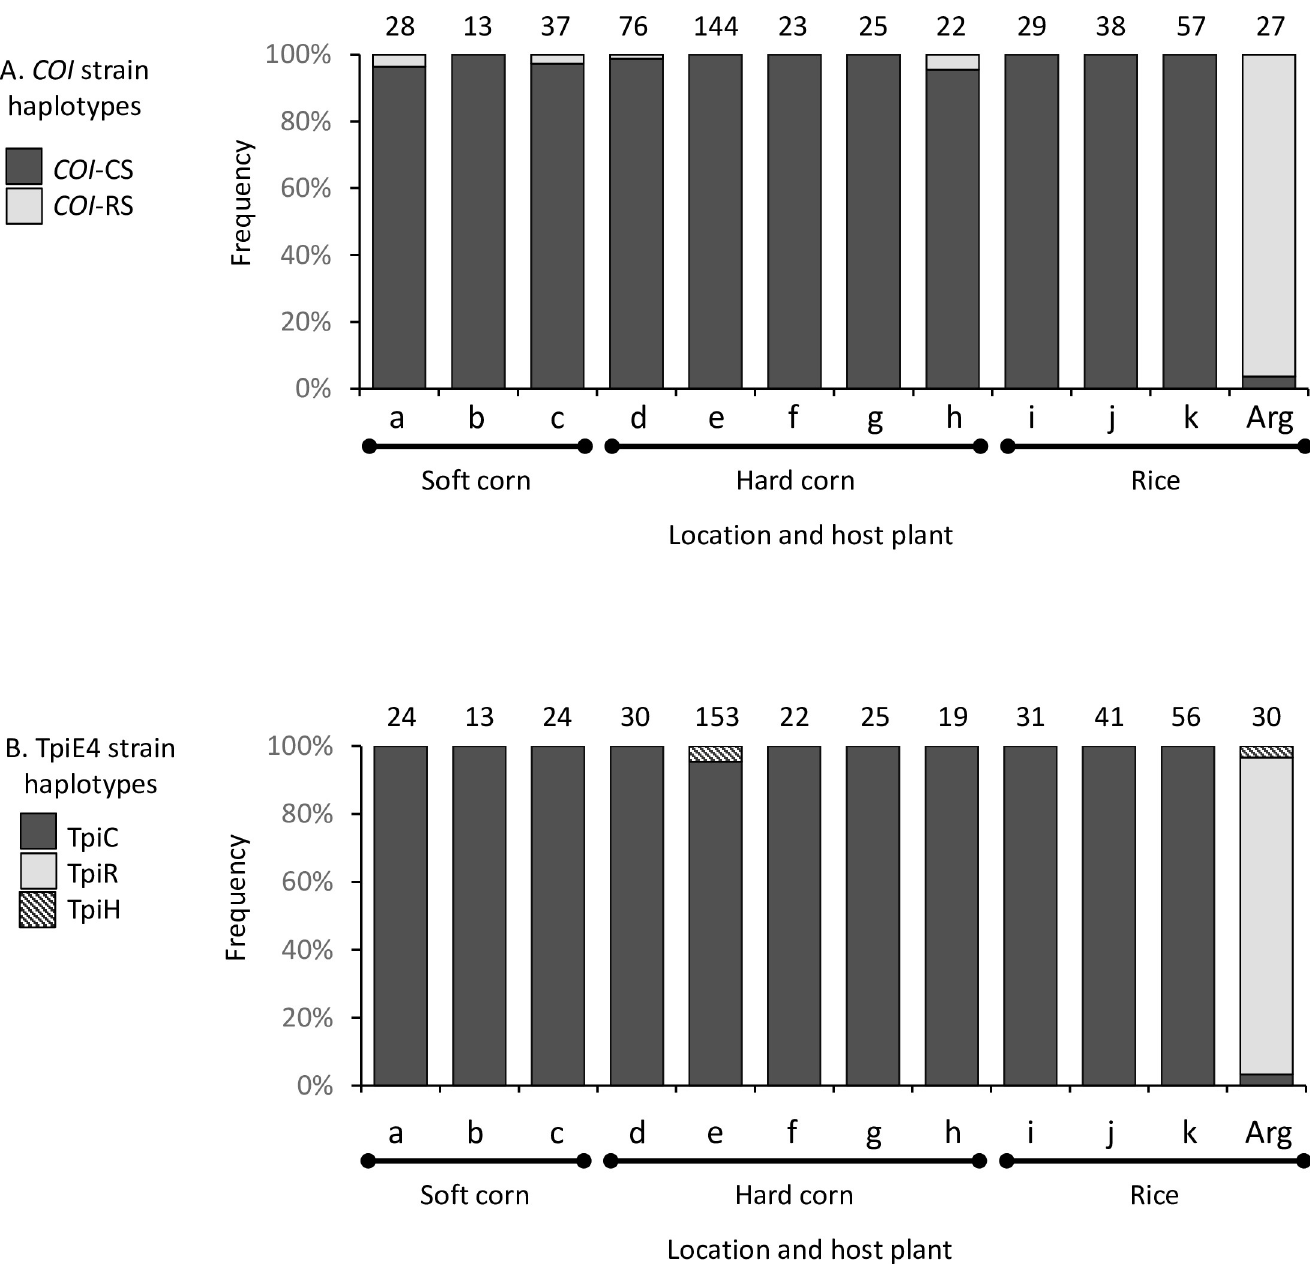
Fig 3. Frequency distributions of the COI and Tpi strain haplotypes in different host plants and locations. Fall armyworms collected from soft corn, hard corn, and rice in Ecuador were compared to collections from Argentina rice (Arg) describe in an earlier study [8]. A, Bar graph shows frequencies of COI -CS and COI -RS at locations described in Table 1. The COI -CS haplotype can be subdivided into four subgroups designated as the COI -h haplotypes. B, TpiE4 haplotype frequencies. Letters denote collection sites described in Table 1. Numbers above bars indicate the number of specimens